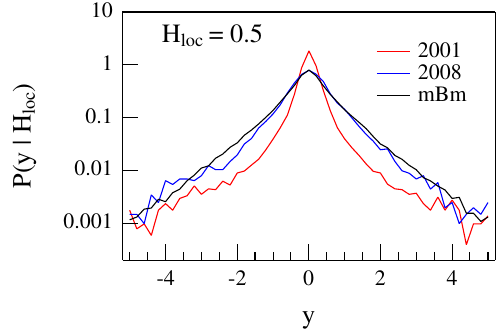
Fig. 17. Comparison of the H loc -conditioned probability distribution functions P ( y | H loc ) of the standard deviation normalized small-scale (1 min) increments for H loc =0 . 5 in the case of the two selected geomagnetic time series and of the synthetic mBm generated according to the algorithm described in Section 2. the conditioned PDFs at low H values in the year 2001 has to be related to the less persistent nature of very large fluctuations occurring during disturbed periods.